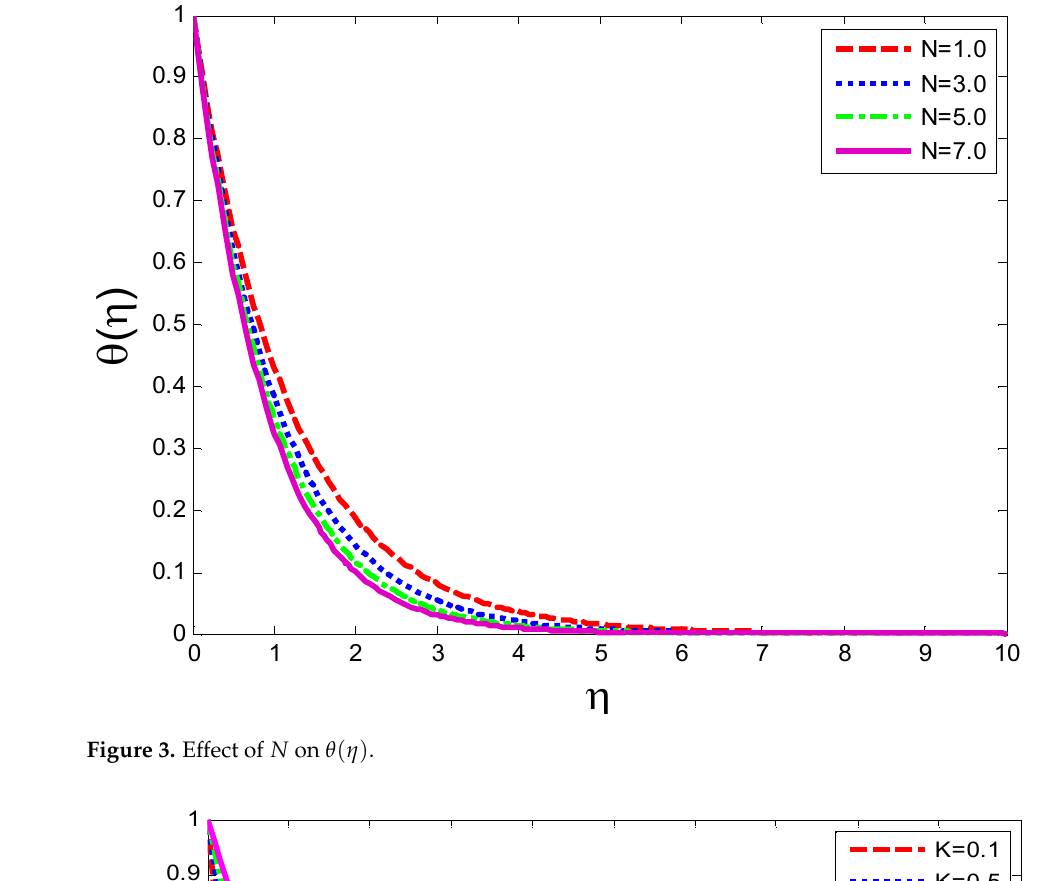
Figure 2. Effect of 𝑅𝑖 on 𝑓 (cid:4593) (cid:4666)𝜂(cid:4667) .